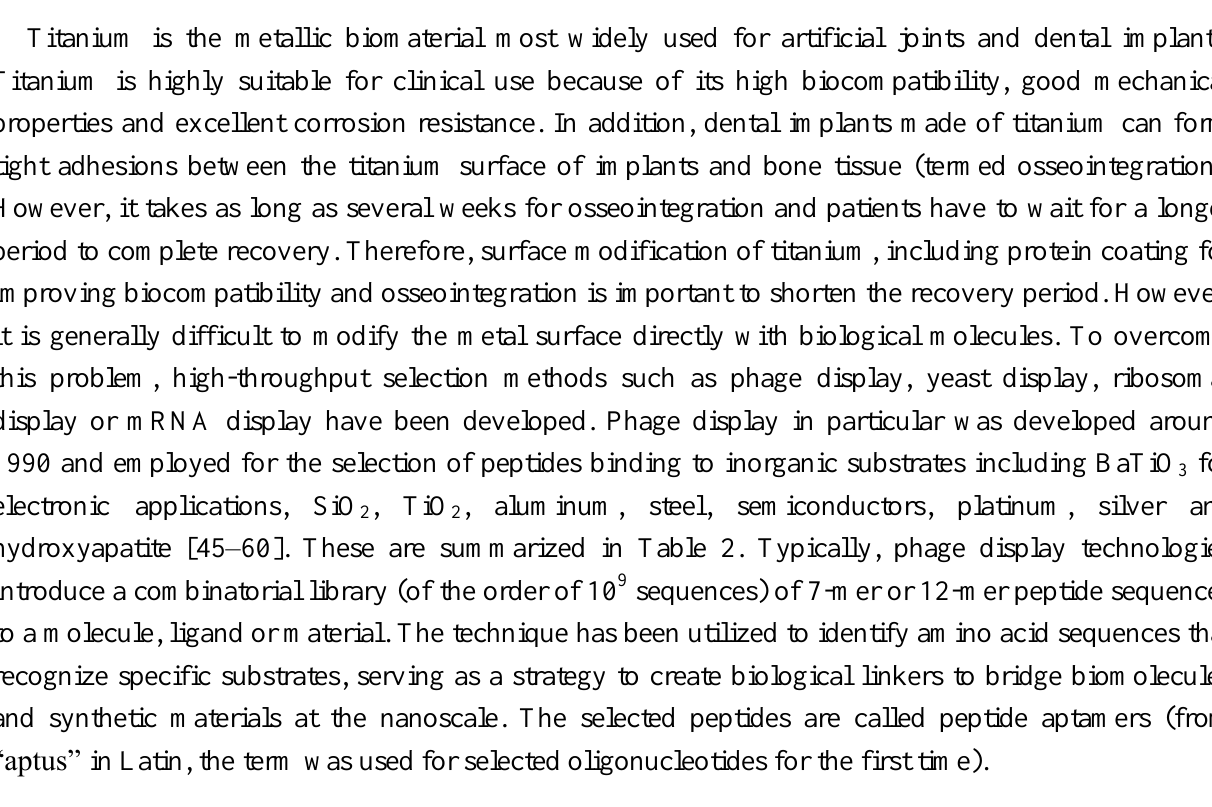
Table 2. List of inorganic material-binding peptides found by phage display. Peptide sequence Binding